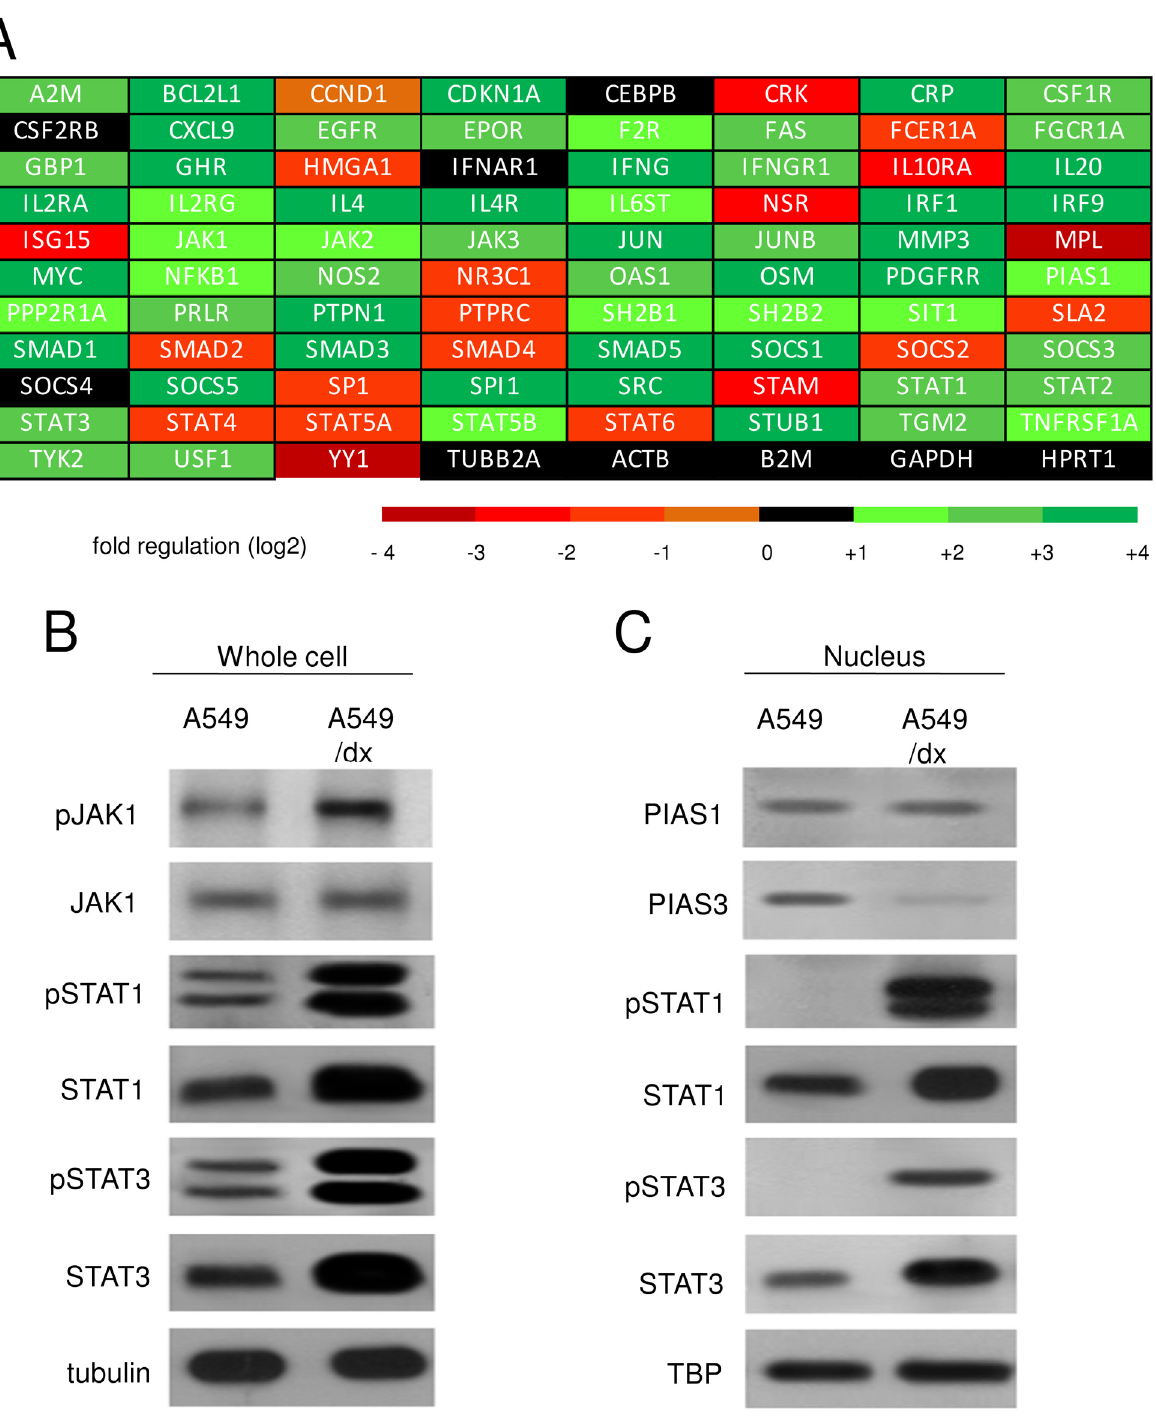
Fig 4. Multidrug resistant cells have a higher activity of JAK/STAT signaling than chemosensitive cells. A. The cDNA from A549 and A549/dx cells was analyzed by a PCR array specific for JAK/STAT signaling, as reported under Materials and methods. The fold regulation of the 83 genes analyzed, expressed in logarithmic scale, is represented in a colorimetric scale. The figure is the mean of 4 experiments. B. The cells were lysed and subjected to the Western blot analysis for phospho(Tyr 1022/1023)-JAK1, JAK1, phospho(Tyr701)-STAT1, STAT1, phospho(Tyr705)-STAT3, STAT3. The β -tubulin expression was used as control of equal protein loading. The figure is representative of 3 experiments with similar results. C. The expression of PIAS1, PIAS3, phospho(Tyr701)-STAT1, STAT1, phospho(Tyr705)-STAT3, STAT3 in nuclear extracts was measured by Western blotting. The TBP expression was used as control of equal protein loading. The figure is representative of 3 experiments with similar